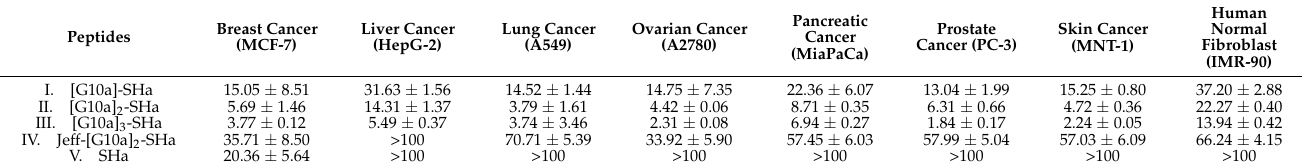
Table 5. Antiproliferative activity of dendrimers on various human cells. Antiproliferative effect of the dendrimers was evaluated through the determination of their inhibitory concentration 50% (IC50), i.e., the concentration of dendrimers inhibiting 50% of the cell proliferation.